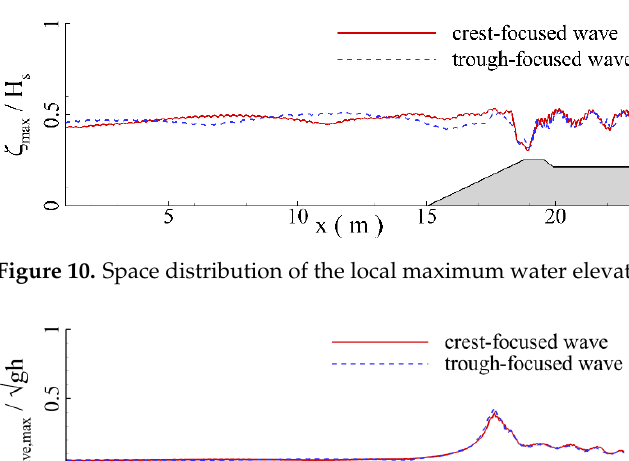
Figure 11. Space distribution of the local maximum depth-averaged velocity.